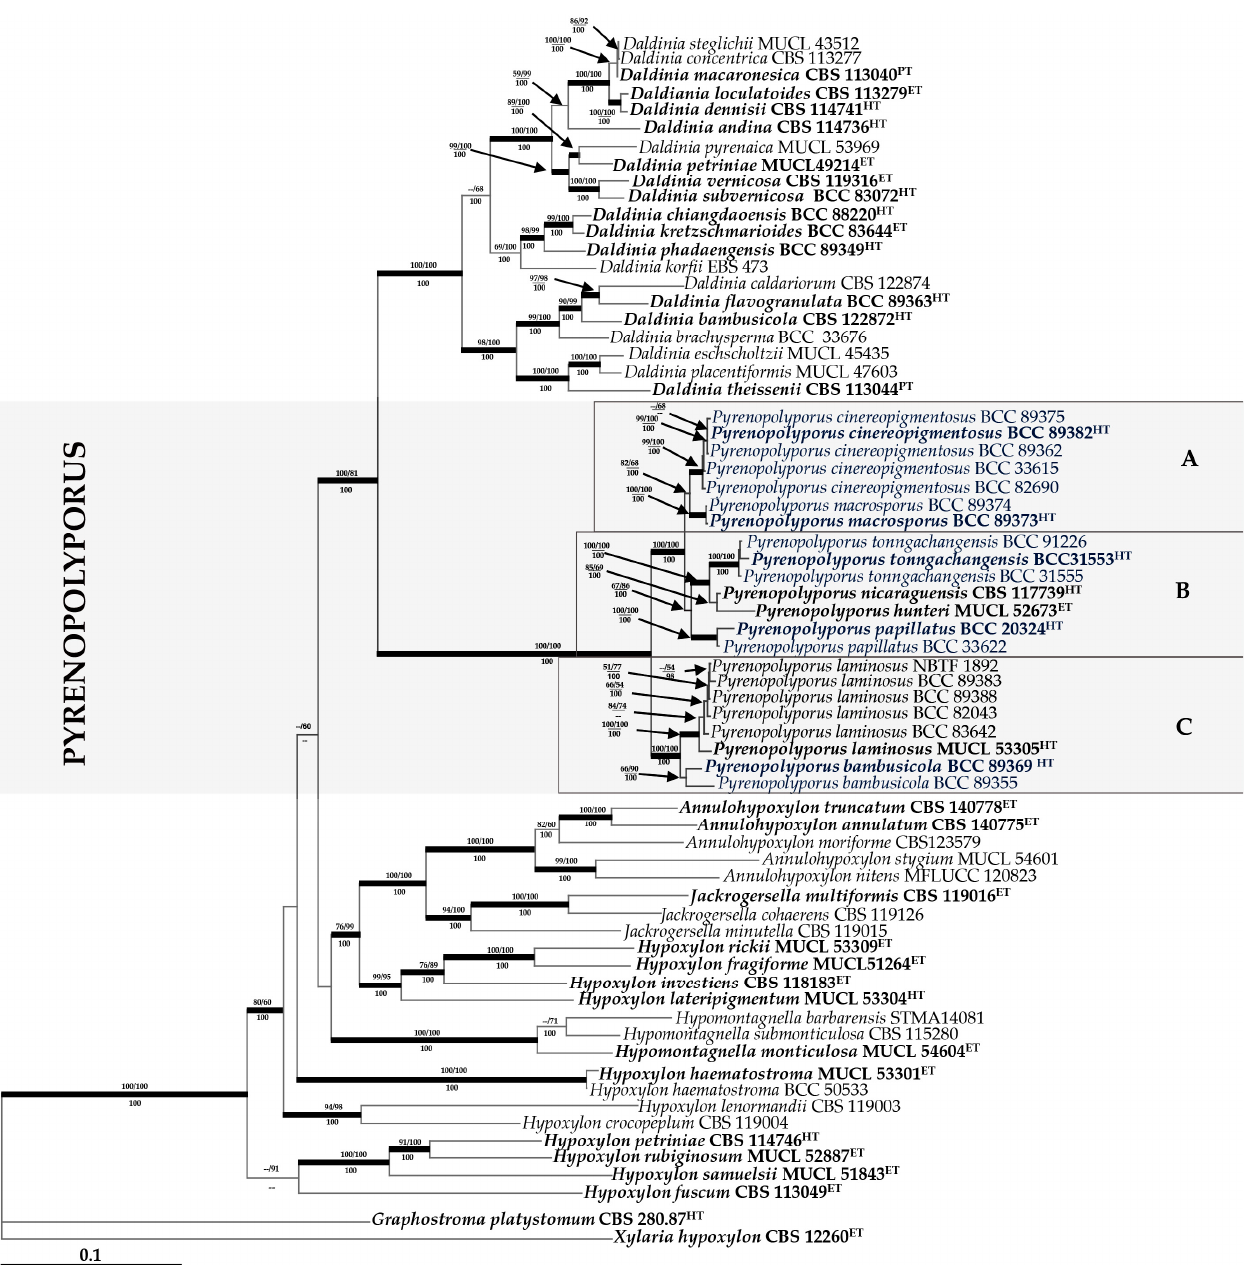
Figure 14. Phylogeny of the Hypoxylaceae. RAxML tree was generated based on multiple loci alignment of concatenated ribosomal (ITS and LSU) and proteinogenic ( TUB2 and RPB2 ) sequence data. Support values were calculated via MP, ML, and Bayesian analyses and are indicated above (MPBS/MLBS) and below (BPP) the respective branches. Branches of significant support (BS ≥ 70% and PP ≥ 100) are thickened. New species are indicated in blue and the clade comprising the sequences of the Pyrenopolyporus spp. is marked by a grey rectangle consisting of subclades A, B and C; ET indicates ex-epitype, HT ex-holotype, and PT ex-paratype strains are highlighted in bold le tt ers.